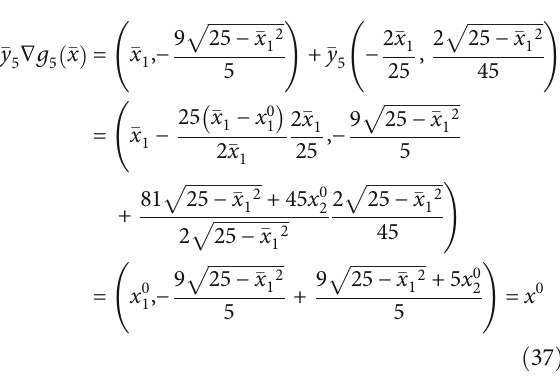
ffiffiffi p 2 /2 Þ = − 5/9 and (cid:2) k 5 1 ð